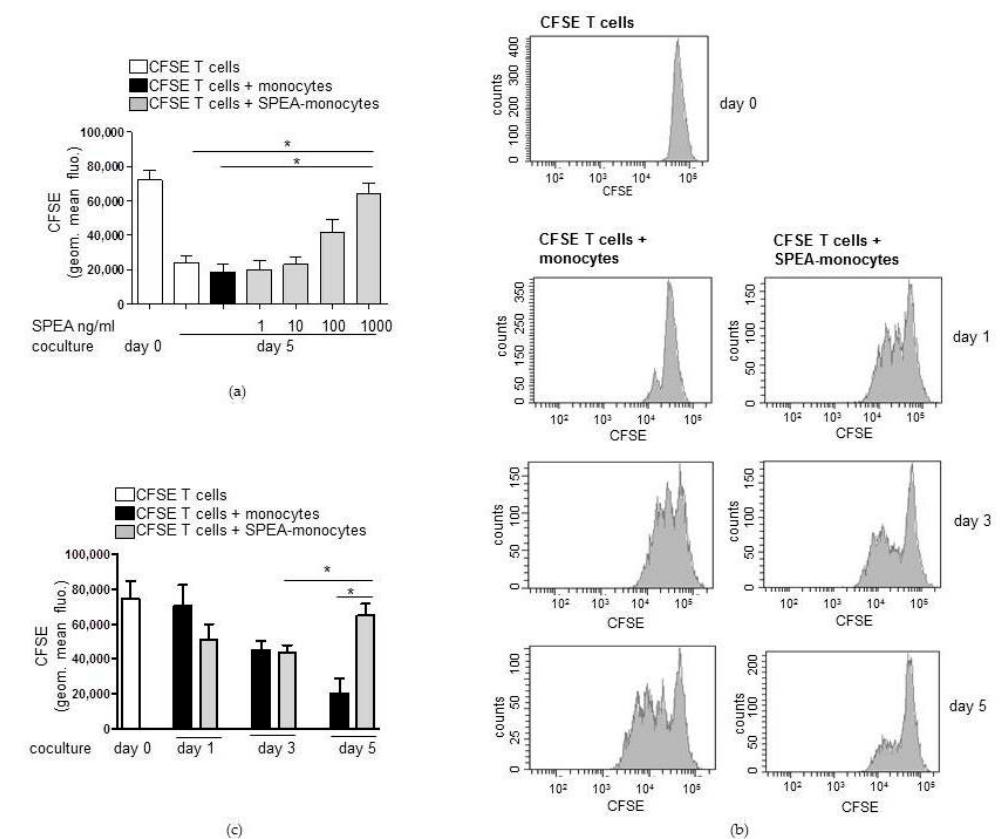
Figure 1. Streptococcal pyrogenic exotoxin A (SPEA)-monocytes decrease numbers of CD3 / CD28-activated cocultured T cells. ( a ) CD14 + cells were isolated from blood, stimulated with 1 ng / mL, 10 ng / mL, 100 ng / mL, or 1000 ng / mL SPEA for 48 h (SPEA-monocytes) or left unstimulated. After washing the monocytes three times with media, cocultures with allogeneic CFSE-labeled, CD3 / CD28-activated CD4 + T cells were started (ratio of 1:2). After five days, cell divisions of T cells were analyzed by determining the CFSE (FITC) signal using a FACSCanto. Shown is the quantification of geometric mean fluorescence of the CFSE signal ( y -axes). The color depicts whether T cells were cultured alone (white) or together with unstimulated monocytes (black) or SPEA-monocytes (grey). ( b ) Monocytes were stimulated with 1000 ng / mL SPEA for 48 h. After washing, CFSE-T cells were added and cultured for one, three, or five days (as labeled in the graph). Depicted are FACS histograms of the CFSE (FITC) signal of T cells. ( c ) Quantification of geometric mean fluorescence of the CFSE signal of T cells at the indicated timepoints. The color depicts whether T cells were cultured alone (white) or together with unstimulated monocytes (black) or SPEA-monocytes (grey). ( a , c ) Columns: mean of three di ff erent donors / experiments ( n = 3) + standard deviation (SD) as error bars. Statistical analysis: the comparison of two data groups was analyzed by Mann–Whitney U test with * p ≤ 0.05. The line above the columns depicts the compared groups. Kruskal–Wallis: ( a ) number of groups: 7; p -value 0.0187; sum value, * the medians vary significantly ( p < 0.05). ( c ) number of groups: 7; p -value 0.0021; sum value, ** the medians vary significantly ( p < 0.05). As the analyzed CFSE signal conveys that many divided T cells disappeared after five days of SPEA-monocyte coculture, apoptosis of lymphocytes was analyzed. We performed annexin V staining to detect cell surface changes associated with early apoptosis events. Annexin-positive (apoptotic) T cells in the SPEA-monocyte coculture remarkably increased from three (around 10%) to five (around 50%) days. Significantly fewer (around 10% at day five) lymphocytes cultured with